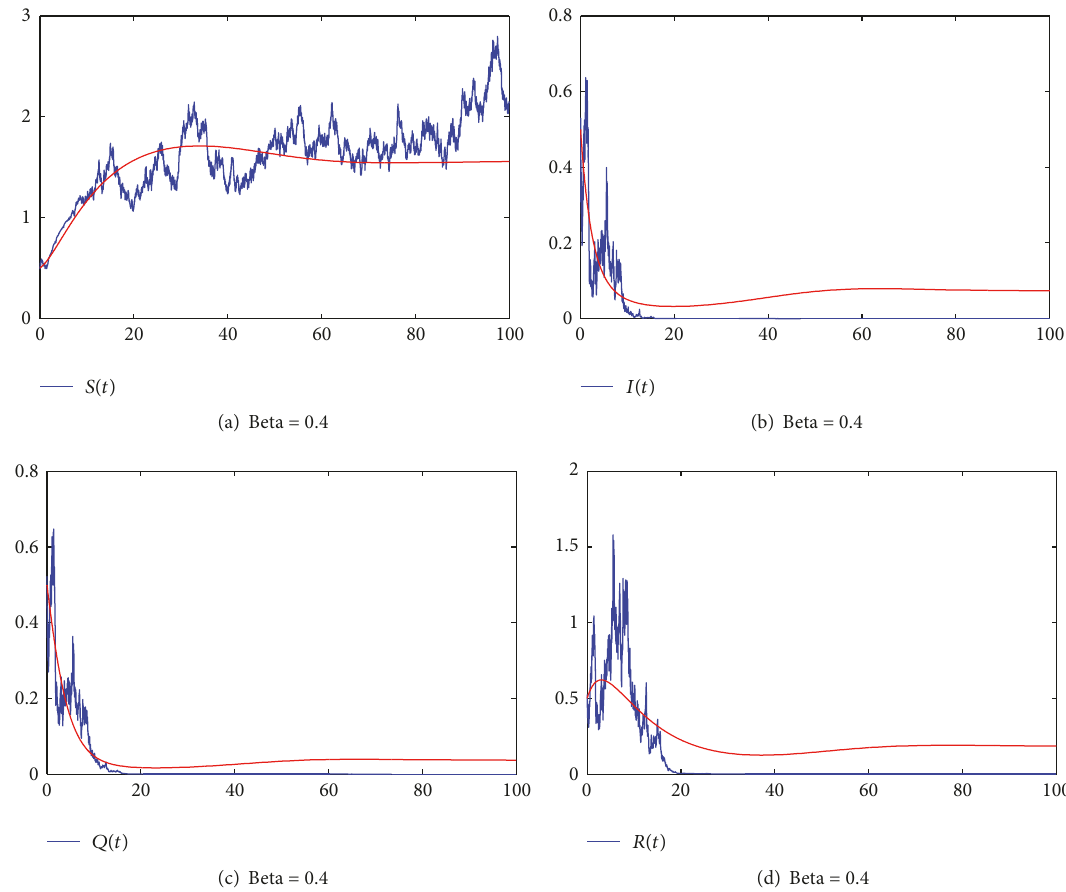
Figure 5: Computer simulation of the paths 𝑆(𝑡), 𝐼(𝑡), 𝑄(𝑡) , and 𝑅(𝑡) for models (1) and (3) for parameter values Λ = 0.2; 𝑑 = 0.1; 𝛽 = 0.7; 𝛾 = 0.2; 𝛿 = 0.2; 𝛼